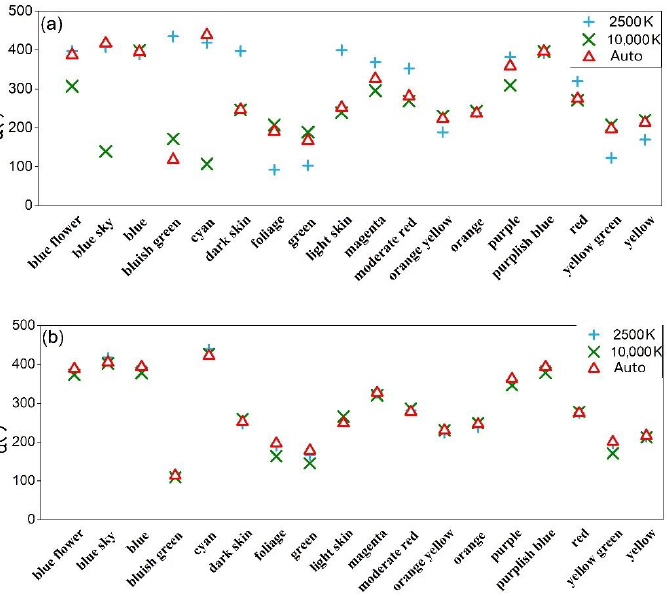
Figure 12. Comparison of chromaticity angle at color temperatures of 2500 and 10,000 K ( a ) before correction and ( b ) after correction with the five-color reference card.